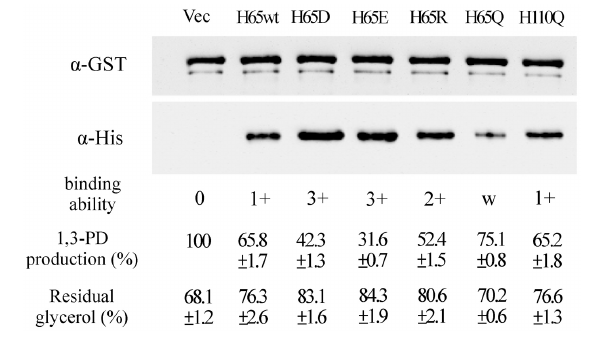
FIGURE 8 | Effects of the interaction between GlpK and the KPN00353 variants on 1,3-PD production. After the interaction of GST-tagged GlpK with wild-type or variant His-tagged KPN00353, the proteins captured on GSH-Sepharose beads were analyzed by Western blotting using either anti-GST antibody ( α -GST) or anti-His antibody ( α -His). From the Western blotting results, we defined the binding affinity of GlpK and wild-type KPN00353 (WT) to be 1+. The binding affinity of GlpK and the KPN00353 variant was comparable to that of GlpK and H65wt. H65wt, E. coli with pET30b::353WT; H65D, E. coli with pET30b::H65D; H65E, E. coli with pET30b::H65E; H65R, E. coli with pET30b::H65R; H65Q, E. coli